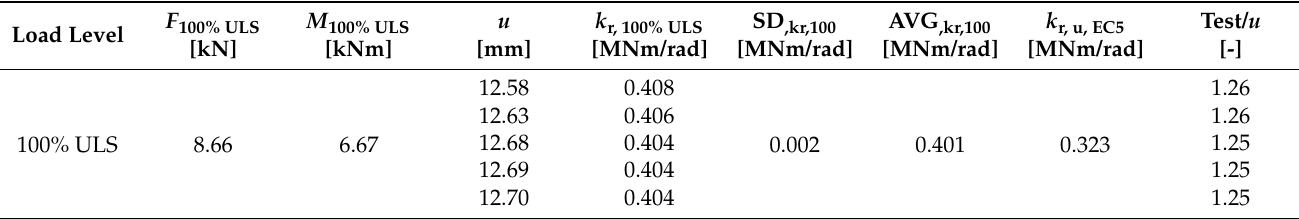
Table 8. Results of quasi ‐ static cyclic testing for Experiment A at 100% ULS.